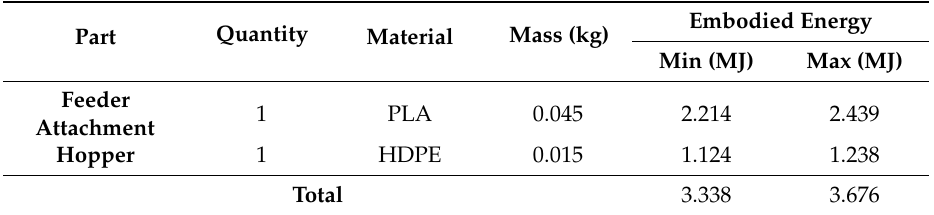
Table 5. Embodied energy for the feeder attachment and hopper part of the